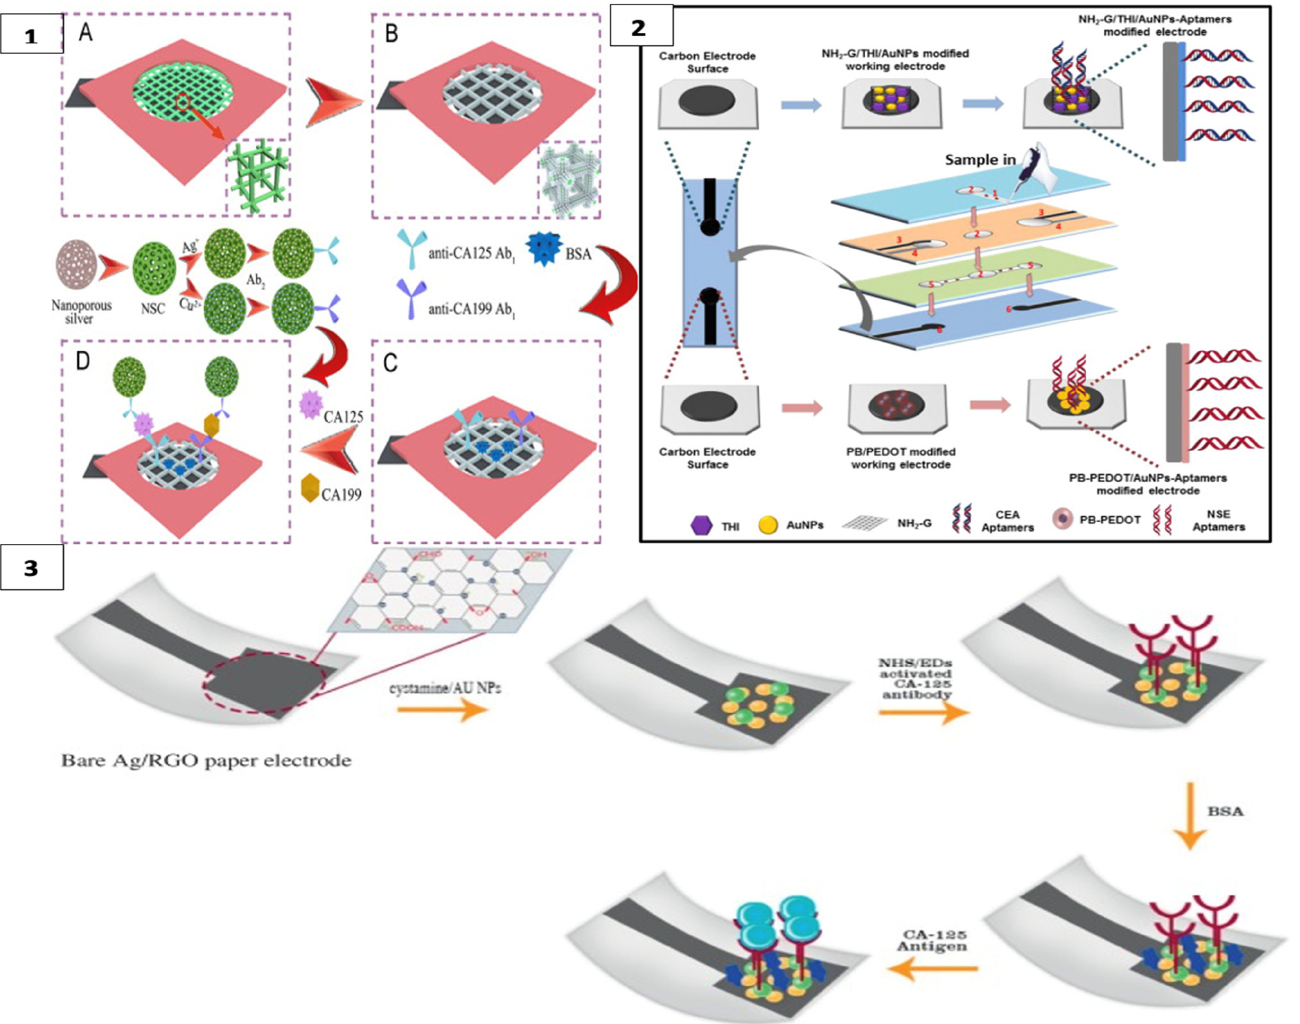
Figure 3. ( 1 ) Cuboid silver-paper electrode-based multiplex electrochemical origami immunodevice